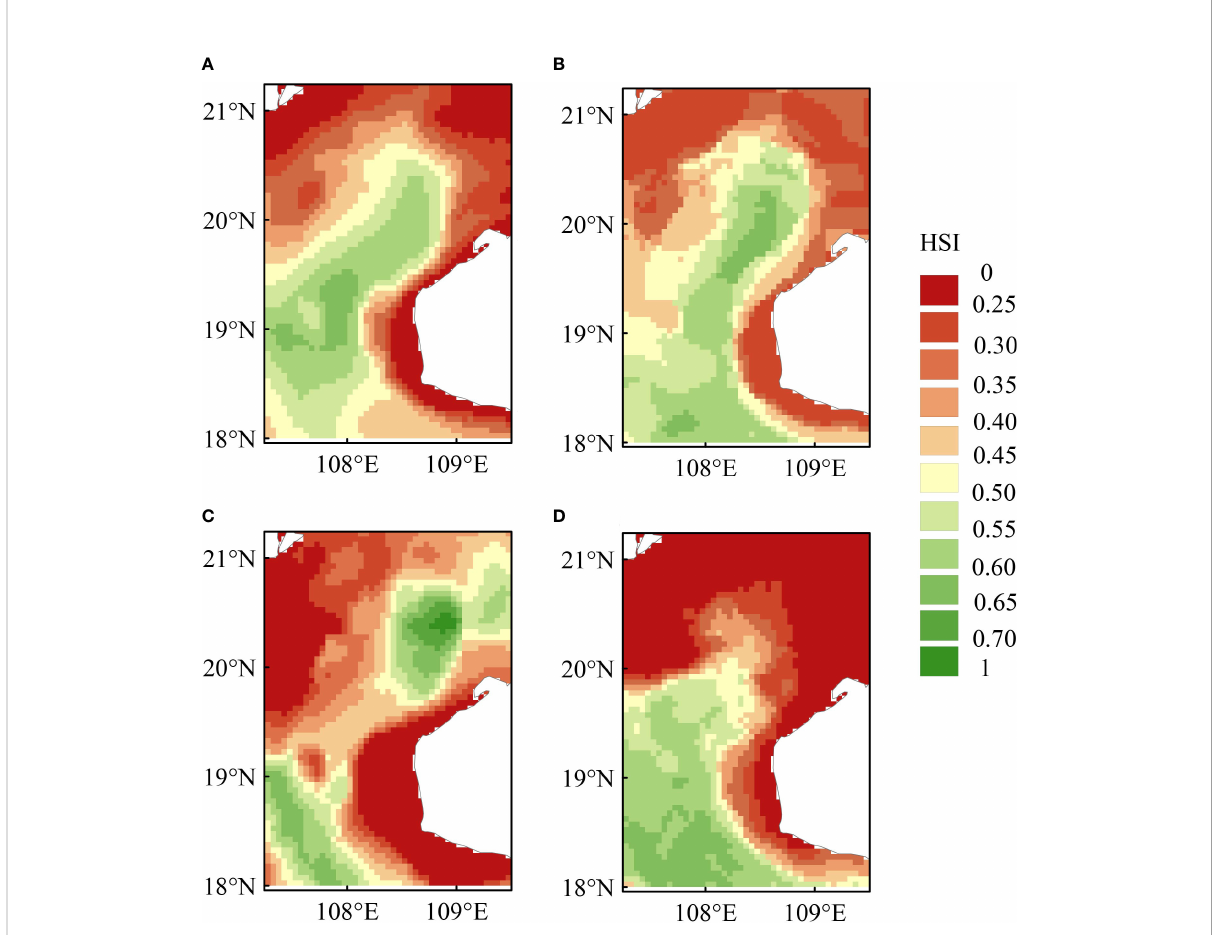
FIGURE 2 The probability of occurrence of Trichiurus japonicus in the Beibu Gulf, South China Sea, in different seasons: (A) spring; (B) summer; (C) autumn; (D)